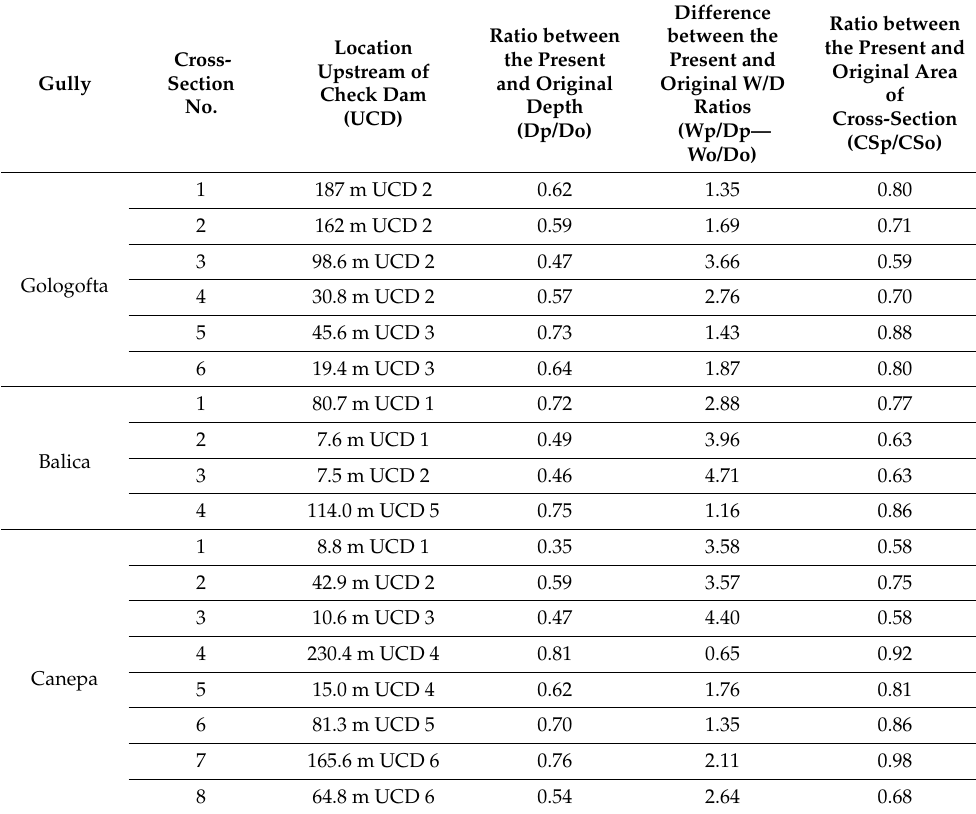
Cross- Section No.